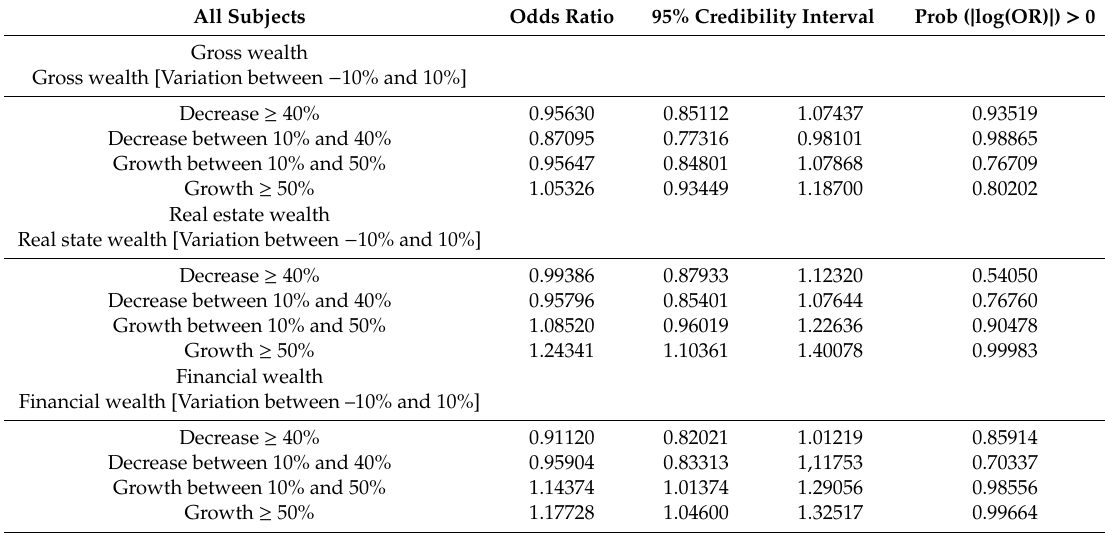
Table 5. Association between the variation in wealth and real income and good and very good self-perceived